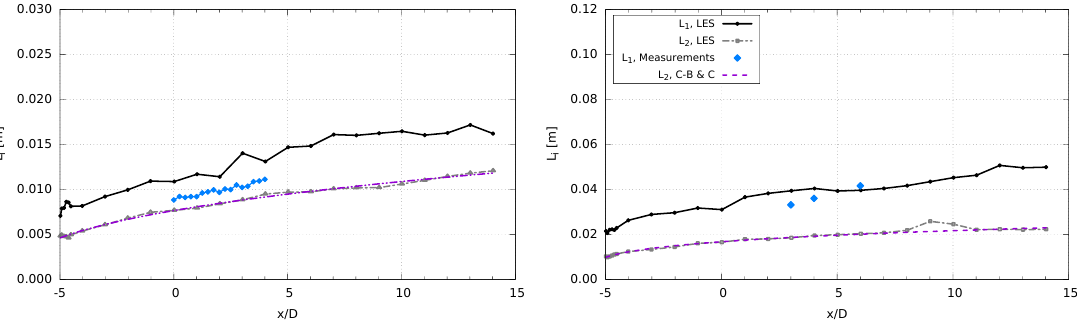
Figure 4. Longitudinal evolution of L 1 and L 2 for the Ti3 ( left ) and Ti12 ( right ) cases without